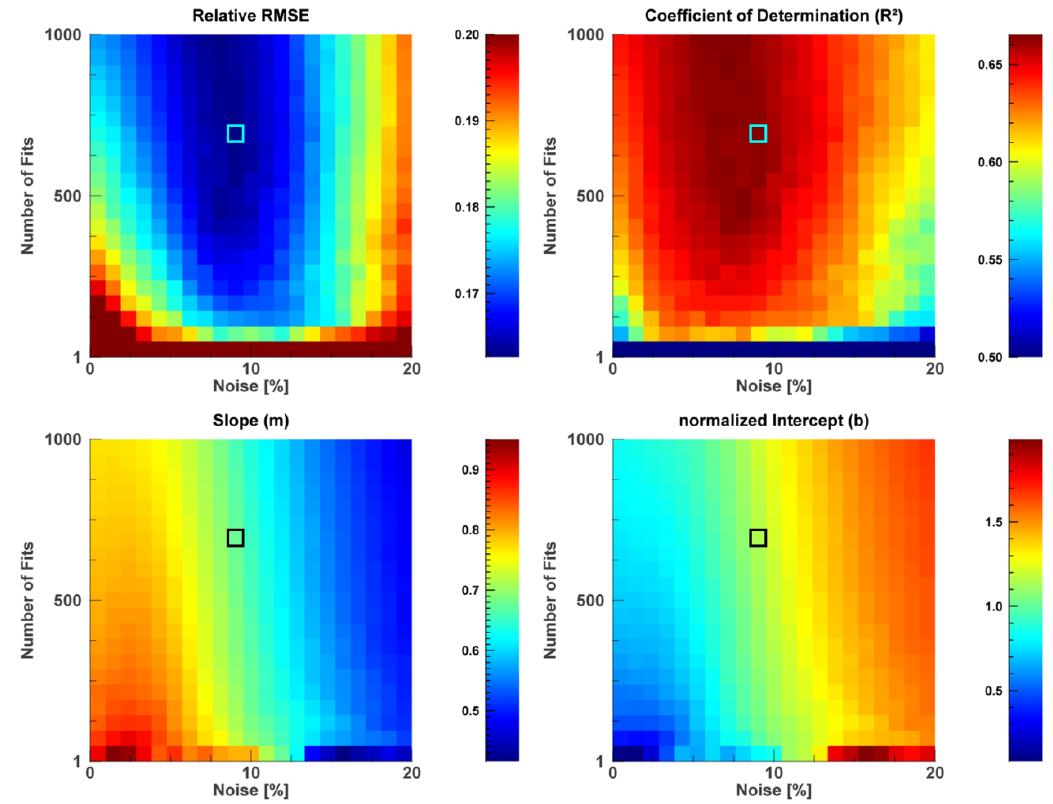
Figure 3. Alternative accuracy matrices (RRMSE, R 2 , m, b) for the Laplace/median combination based on inverse-multiplicative noise, which has been identified as resulting in the highest accuracy based on the NSE. The marked square shows the position of the best solution selected by the